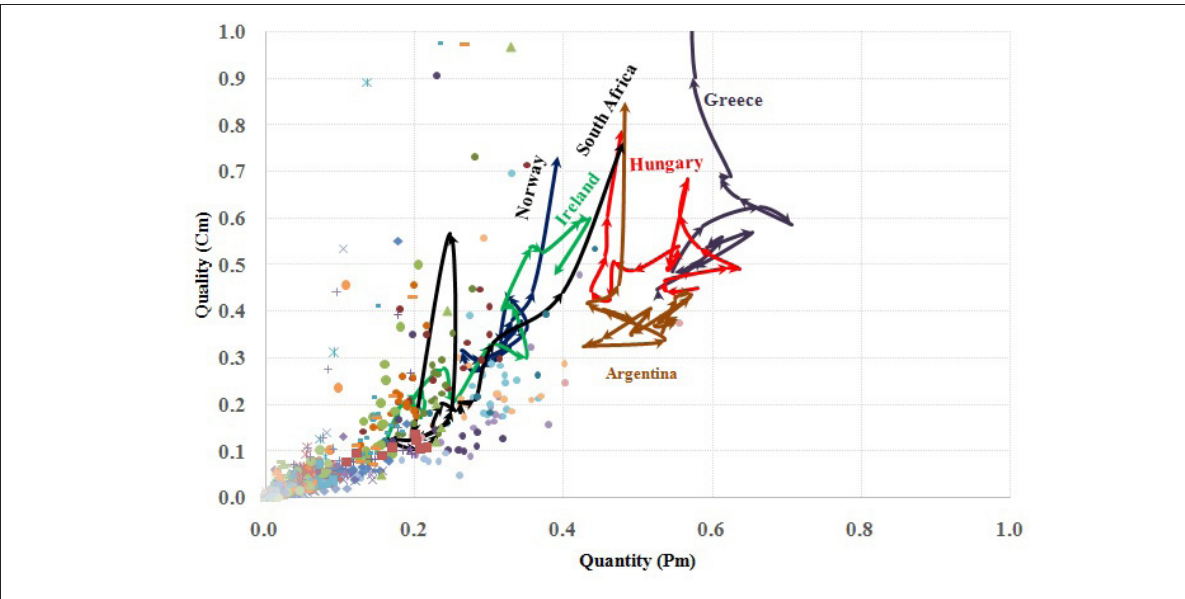
Figure 7: Selected countries of ‘low’ ranking (note the rapid growth for Greece and South